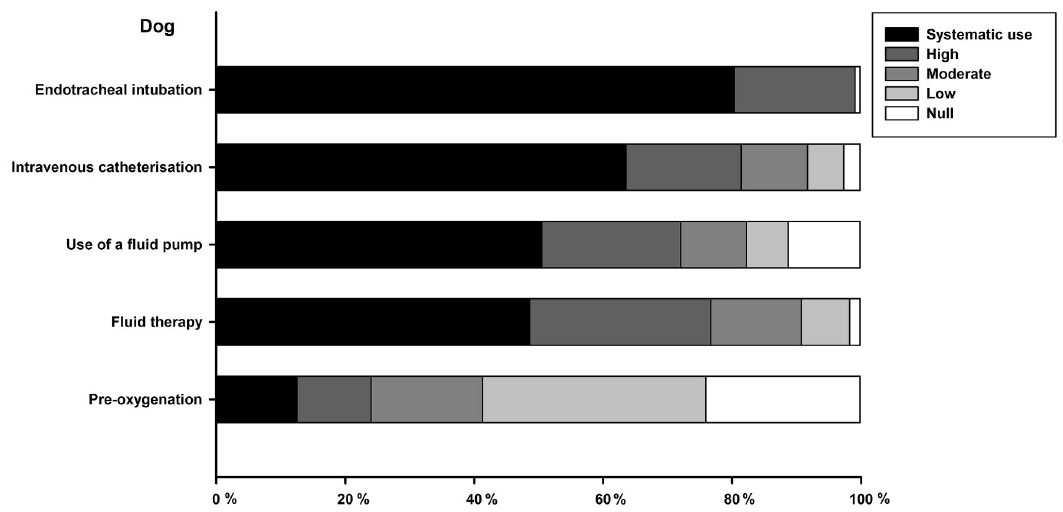
Fig 3. Cumulative percentage of respondents reporting their frequency of use for each technical procedure performed for dog anaesthesia. Frequency of use is color-coded, as systematic (or 100%), high (61 to 99%), moderate (21 to 60%), low (1 to 20%) or null (or 0%).